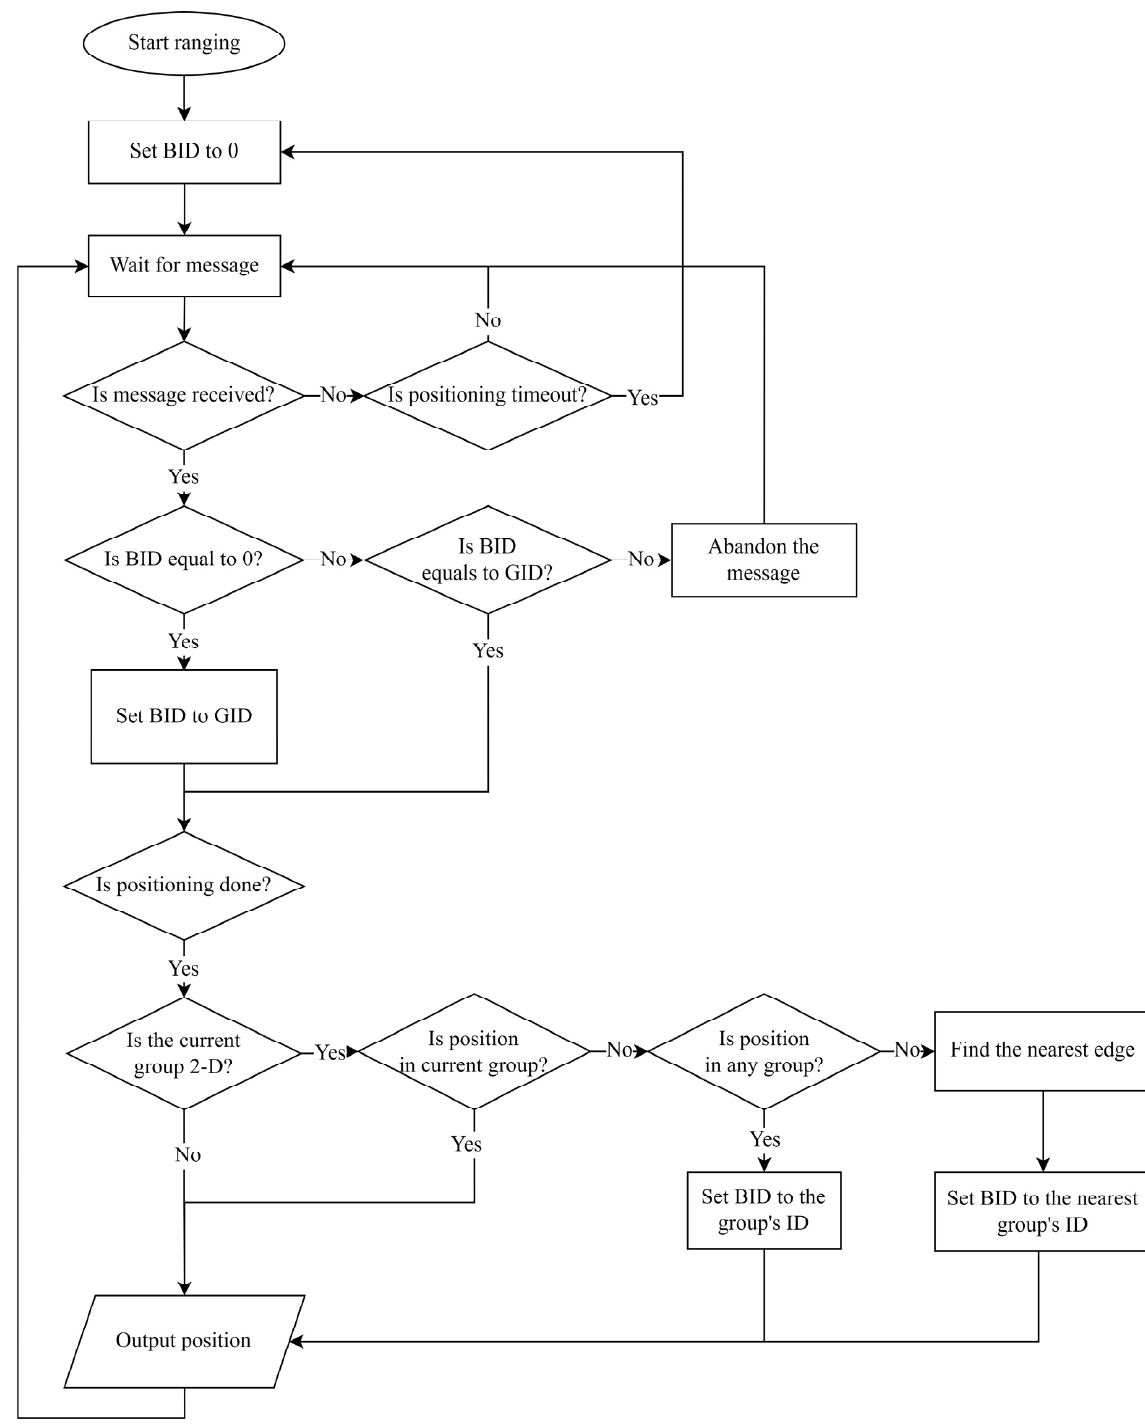
Figure 17. Process of switching group.